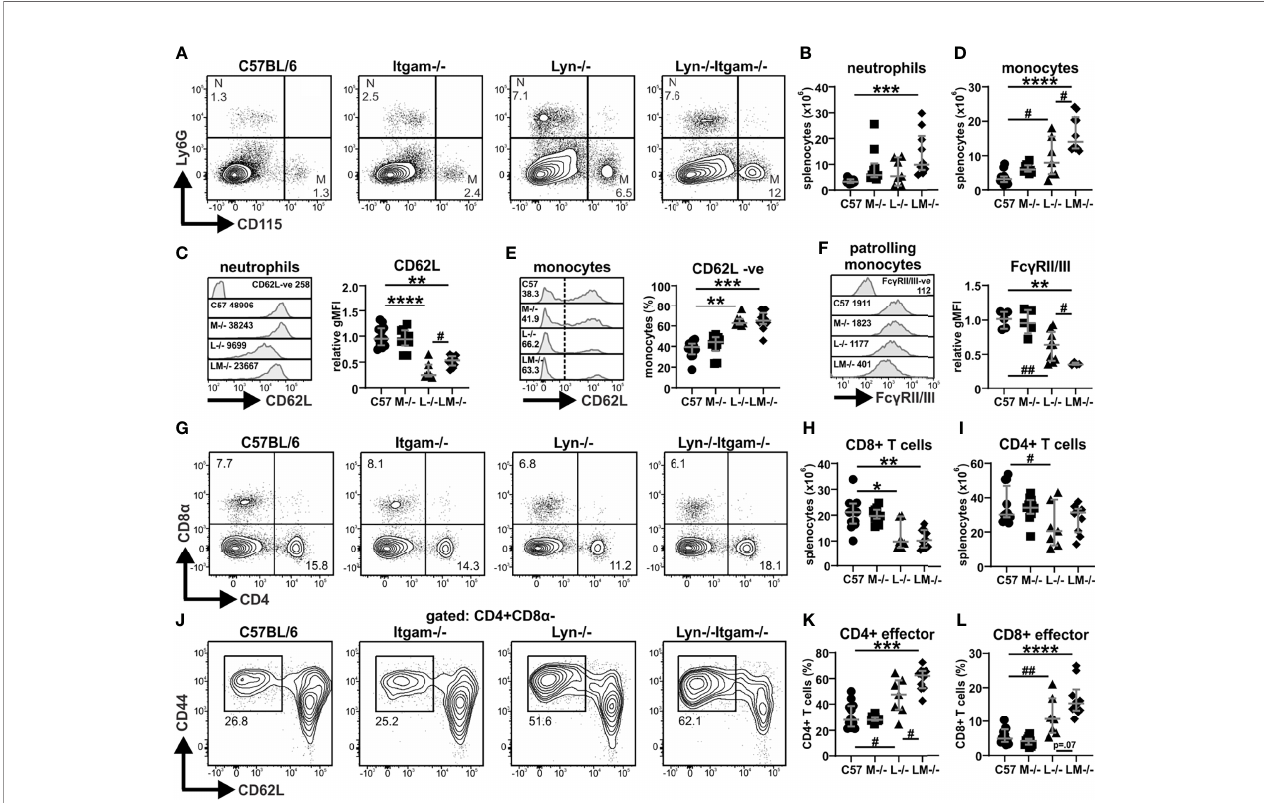
FIGURE 3 | CD11b-de fi ciency augments splenic immune cell defects in Lyn -/- mice. Spleens from the indicated groups of 24-week-old mice were assessed by fl ow cytometry for: (A) proportions of neutrophils (Ly6G + CD115 - ) and monocytes (CD115 + Ly6G - ); (B) numbers of neutrophils with (C) relative expression of CD62L on neutrophils; (D) numbers of monocytes with (E) proportions of CD62L- non-conventional/patrolling monocytes and (F) relative expression of Fc g receptors II and III on patrolling monocytes; (G) proportions of CD8+ (CD8 a + CD4 - ) and CD4+ (CD4 + CD8 a - ) cells with numbers of (H) CD8+ T cells and (I) CD4+ T cells; (J) proportions of effector (CD44 + CD62L - ) CD4+ T cells with numbers of (K) CD4+ effector T cells and (L) CD8+ effector T cells. For data in (B – F, H, I, K, L) , n = 7-12 per group, pooled from three experiments. Flow plots and histograms in (A, C, E – G, J) are representative of three experiments. The negative expression control histograms (CD62L-ve in C , Fc g RII/III-ve in F) were derived by gating on C57BL/6 splenocytes that do not express the respective markers. *p < 0.05, **p < 0.01, ***p < 0.001, ****p < 0.0001 by Dunn ’ s multiple comparisons test and p value stated if approaching signi fi cance (p < 0.1), # p < 0.05, ## p < 0.01 by Mann-Whitney U